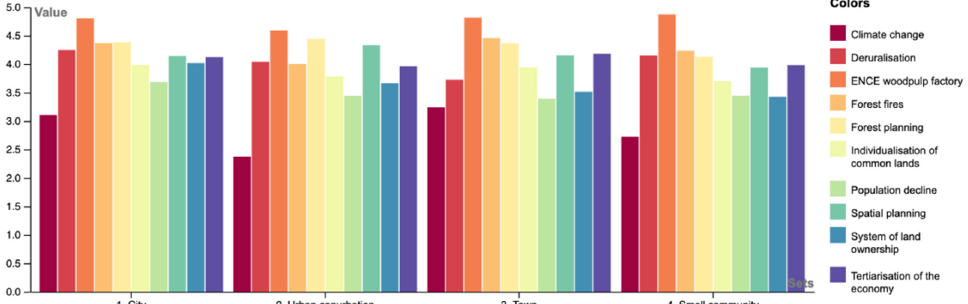
Figure 4. Bar chart displaying, on a scale of 1 to 5, with 1 being “irrelevant” and 5 “crucial”, how activists rate the relevance of contextual factors on the expansion of eucalyptus plantations. Figure produced with RawGraphs.